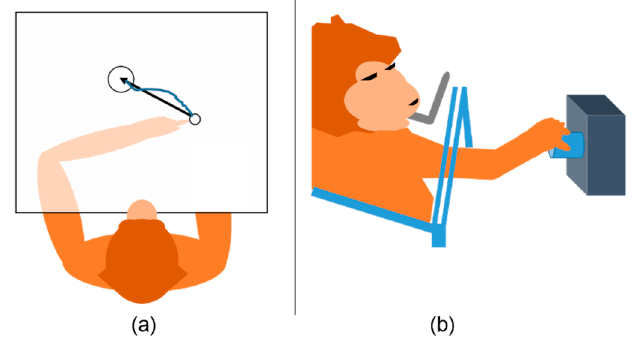
Figure 2. Behavioral tasks. ( a ) Monkey Indy reached a target presented on a horizontal plane. An opaque barrier directly blocked visual feedback from the arm so that monkey Indy could not see his arm. The black arrow presents the movement vector when monkey Indy started to reach the target. The blue curve shows the motion trajectory. ( b ) Monkey N performed an instructed delayed reach-to-grasp task by grasping an object with a side grip and then pulling it.